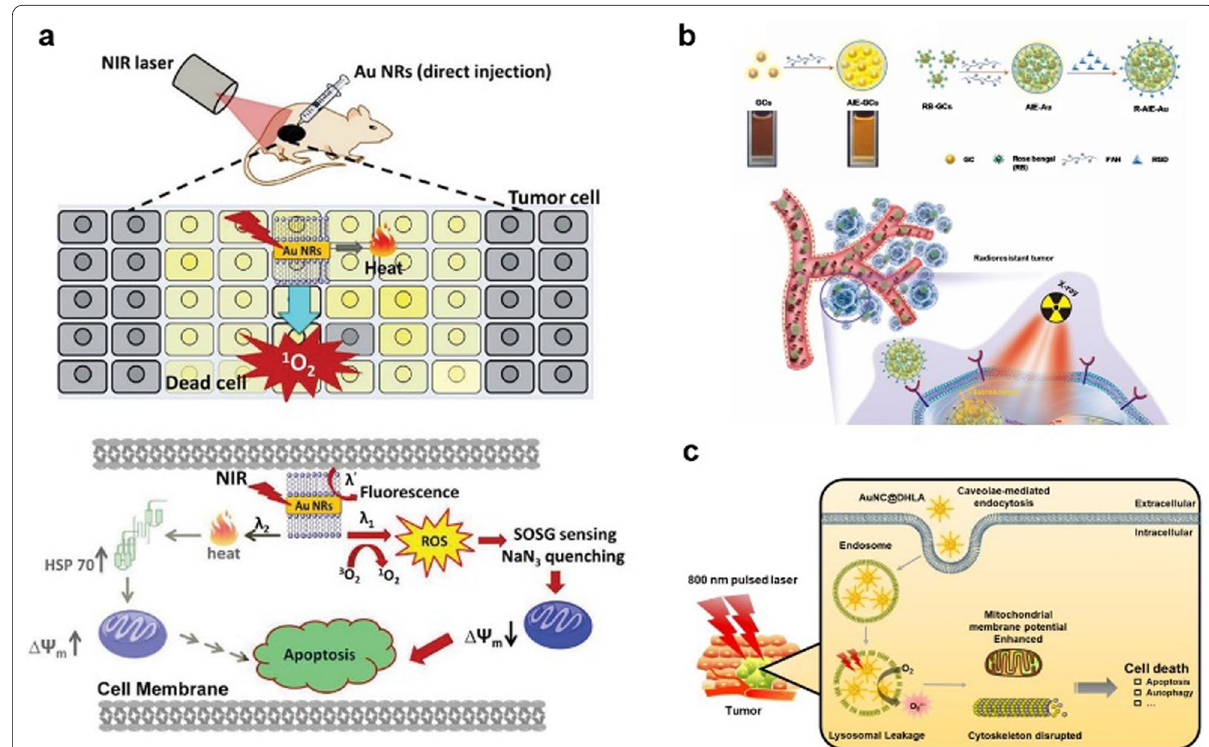
Fig. 4 a Schematic working mechanisms of photothermal and photodynamic therapy effects exerted by Au NRs at low light doses. b Schematic diagrams of the working model of R-AIE-Au for fluorescence and CT imaging-guided X-ray-induced enhanced RT and PDT. c Schematic illustration of the cancer therapy mechanism of AuNC@DHLA PDT. AuNC@DHLA can be internalized via caveolae-mediated endocytosis and accumulate in lysosomes, where the generation of ROS leads to LMP. Subsequent altered MMP, mitochondrial morphology, and cytoskeleton destruction finally lead to cell death. The in vivo PDT was achieved with NIR fs laser irradiation